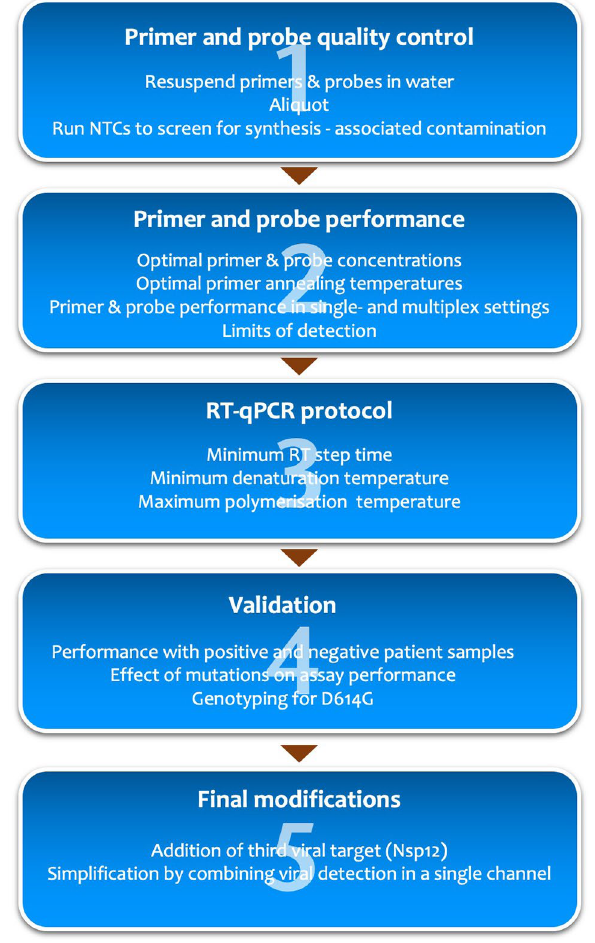
Figure 1. MIQE-compliant workflow used to characterise, optimise and validate the components that make up CoV2-ID